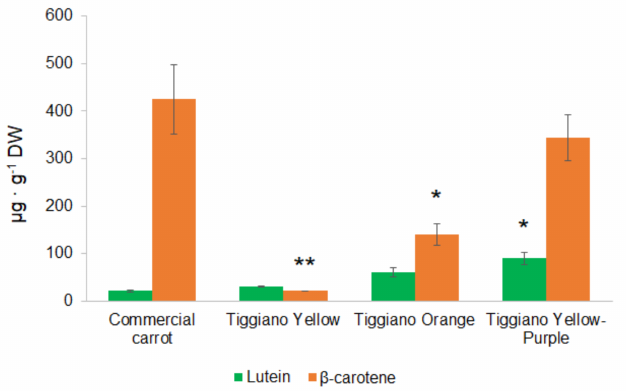
Figure 3. ( a ) Main organic acids and ( b ) sugars detected in Tiggiano carrots compared to the commercial cultivar. Data are expressed as mean ± SD. Significance assumed at * p < 0.05, ** p < 0.01.